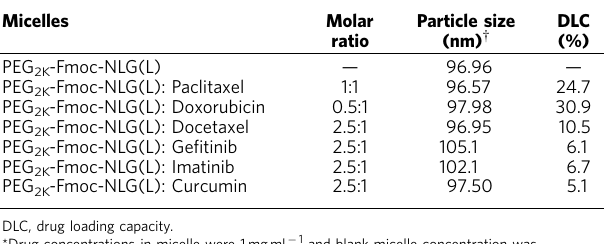
suggesting that NLG was slowly but continuously released from the conjugate over a prolonged period of time. Figure 4c,d shows the total amounts of NLG in tumours and other major organs/ Table 1 | Biophysical characteristics of anticancer drug- tissues at various times following i.v. administration of either loaded PEG 2K -Fmoc-NLG(L) micelles and blank micelles.* PEG 2k -Fmoc-NLG or NLG/PEG 5k -(Fmoc-Boc) 2 mixed micelles. Figure 4e shows the blood PTX kinetics in BALB/c mice as a function of time following i.v. bolus administration of PTX-loaded Micelles Molar Particle size DLC ratio (nm) w (%) PEG 2k -Fmoc-NLG(L) and Taxol. It is apparent that PTX/PEG 2k - PEG 2K -Fmoc-NLG(L) — 96.96 — Fmoc-NLG(L) remained in the circulation for a significantly longer PEG 2K -Fmoc-NLG(L): Paclitaxel 1:1 96.57 time compared with Taxol. The pharmacokinetic parameters are outlined in Table 3. Incorporation of PTX into PEG 2k -Fmoc- NLG(L) micelles resulted in significantly greater t 1/2 , area under curve (AUC), and C max over Taxol. Meanwhile, volume of distribution (Vd) and clearance (CL) for PTX/PEG 2k -Fmoc- DLC, drug loading capacity. NLG(L) were significantly lower than those for Taxol. *Drug concentrations in micelle were 1mgml (cid:2) 1 and blank micelle concentration was Figure 4f shows the biodistribution of PTX in 4T1.2 20mgml (cid:2) 1 . w Measured by dynamic light scattering sizer. tumour-bearing mice 24 h following i.v. administration of PTX-loaded PEG 2k -Fmoc-NLG(L) micelles or Taxol. Significantly NATURE COMMUNICATIONS|7:13443|DOI: